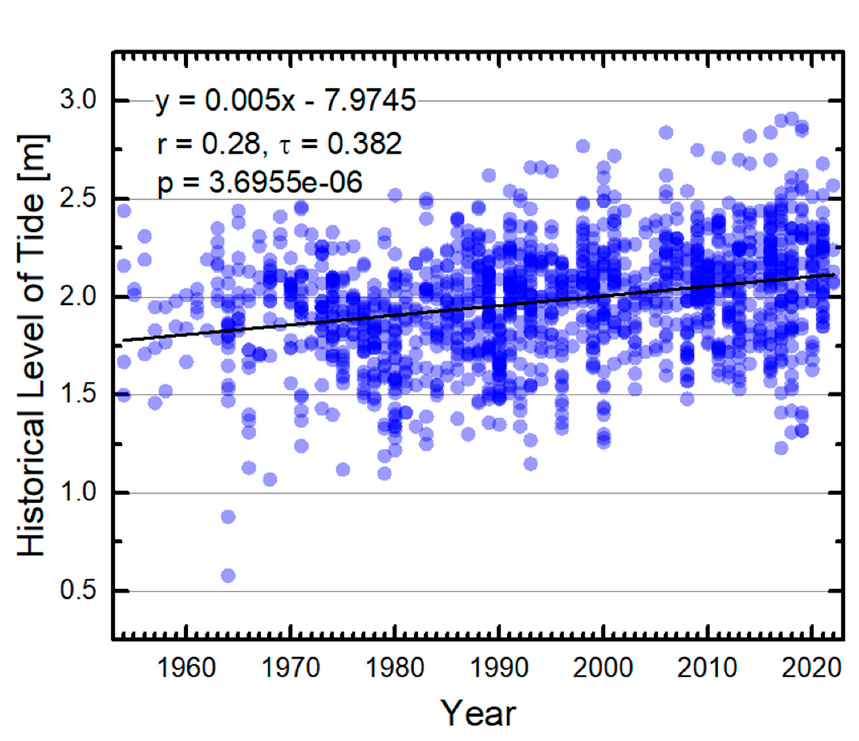
Figure A3. Historical level of tide (meters).